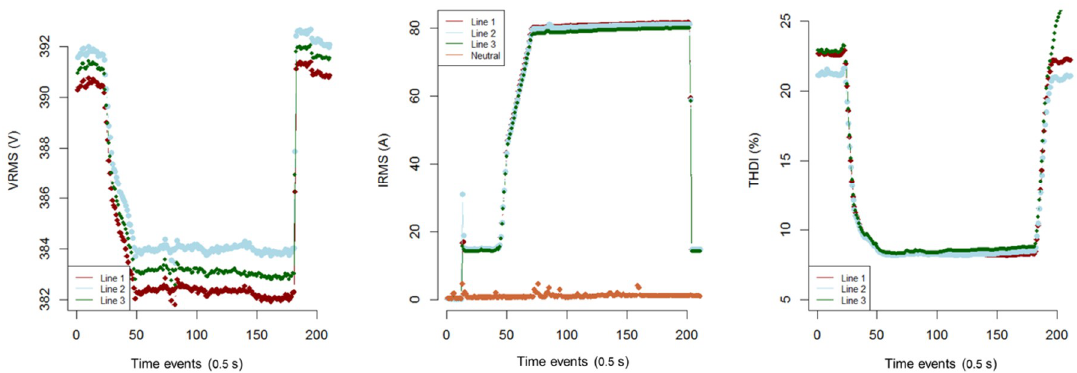
Figure 5. Three-phase voltages, currents, and THD I , during the charging process for charger D, at 40 °C.